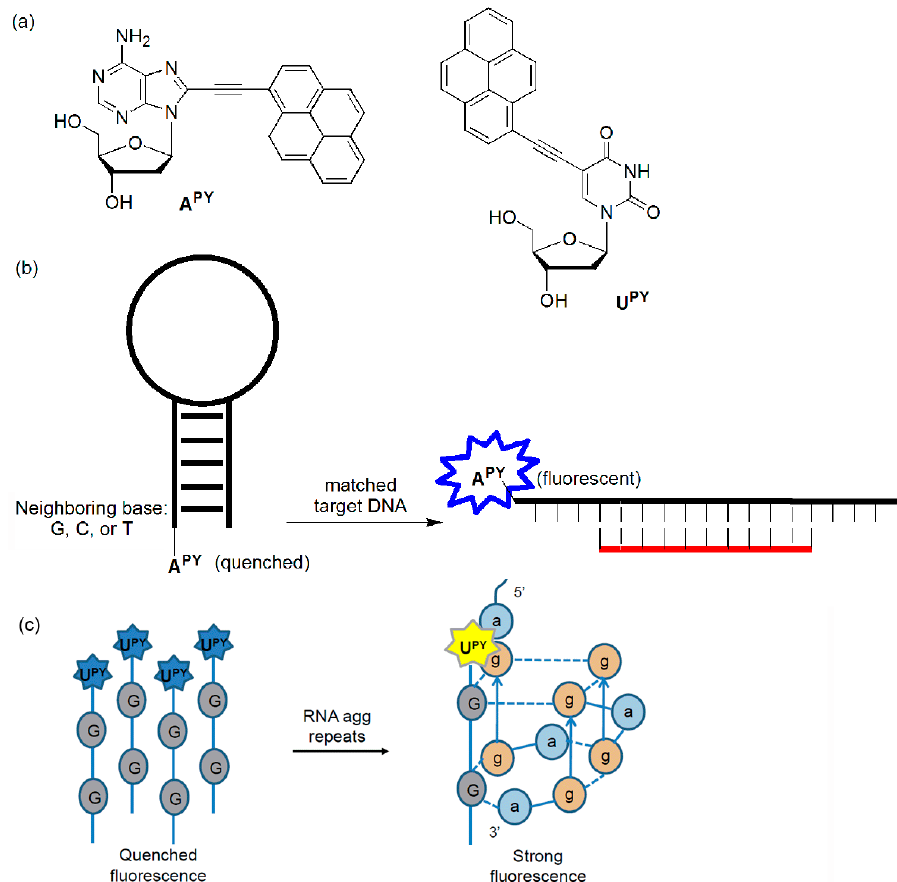
Figure 11. ( a ) A PY and U PY , ( b ) A Py -labeled probe, and ( c ) probe for agg trinucleotide repeats.